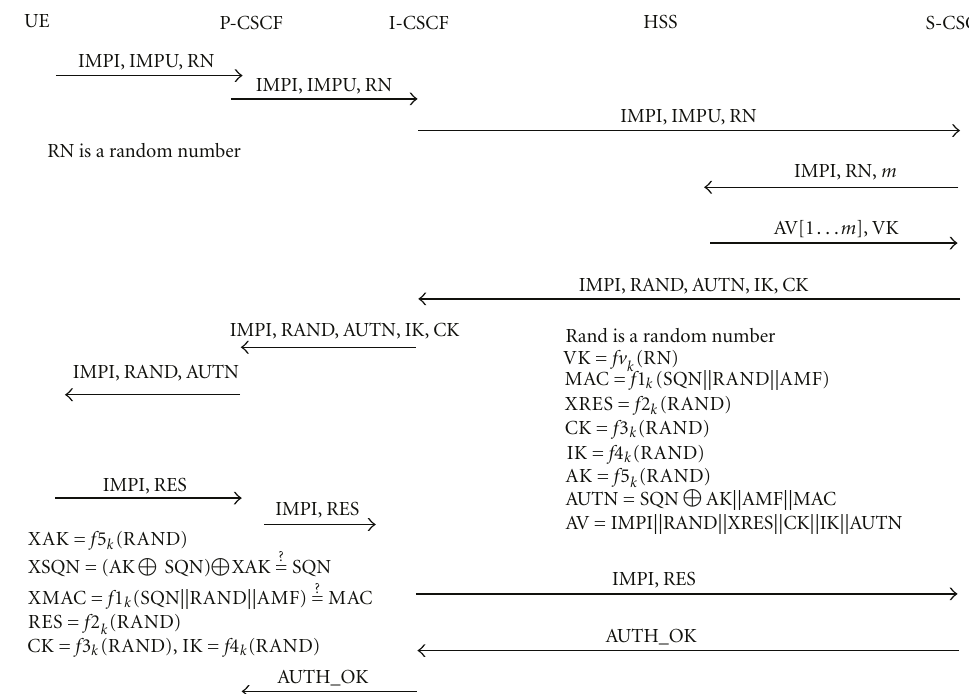
Figure 6: The proposed